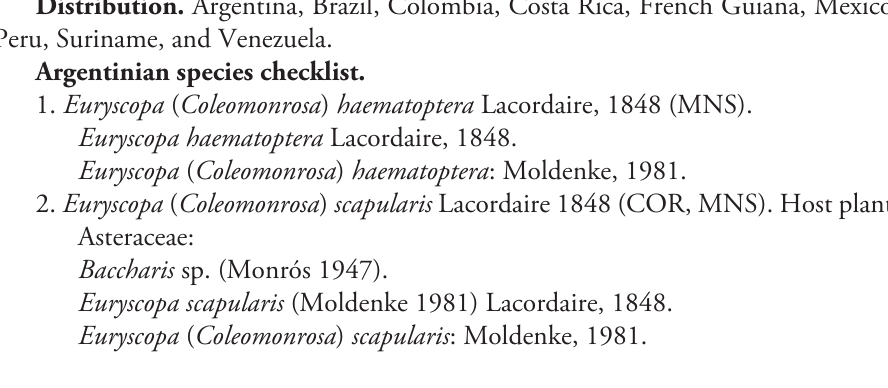
Type species. Euryscopa semicincta Lacordaire, 1848, designated by Moldenke 1981: 94. Diagnosis. Size greater than 7mm; robust, widest at humeral angle; scutellum foveate; aedeagus occupying entire abdominal length, distinctly straight; body not metallic, eyes weakly emarginate; antennomere IV smaller than V; elytral puncta- tion seriate or sub-seriate, without pubescence; pygidium with transverse subapical